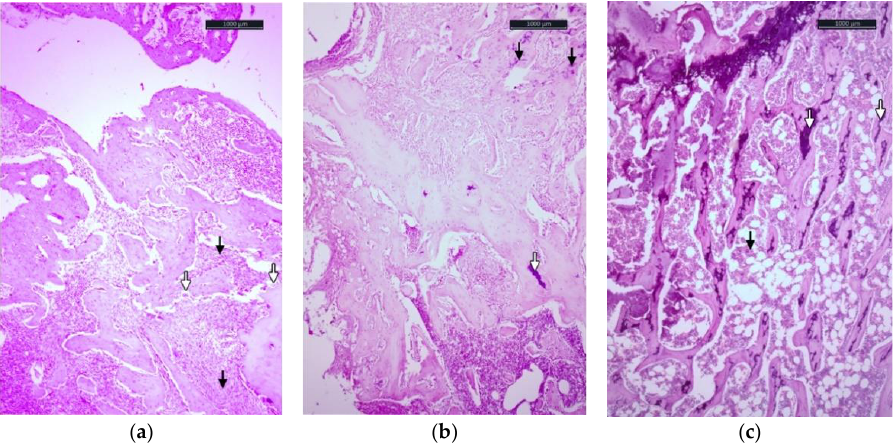
Figure 3. Bone tissue of a rat in the area of a fracture in the femoral diaphysis on the 60th day of the experiment: ( a ) rat without an implant: chains of osteoblasts on the surface of bone trabeculae (marked with arrows ⇒ ); among fibrous tissue, foci with osteogenesis imperfecta (marked with an arrow → ); HE × 100. ( b ) rat with magnesium implants coated with hydroxyapatite: bone mineralization (marked with arrows ⇒ ), focus of perichondral ossification (marked with an arrow → ); HE × 100. ( c ) a rat with a magnesium implant coated with hydroxyapatite, sealed with polytetrafluoroethylene: lamellar cancellous bone with filling of the interbeam space with bone marrow (marked with an arrow → ), bone trabeculae with completed mineralization (marked with arrows ⇒ ). Staining with hematoxylin and eosin at constant magnification; HE ×